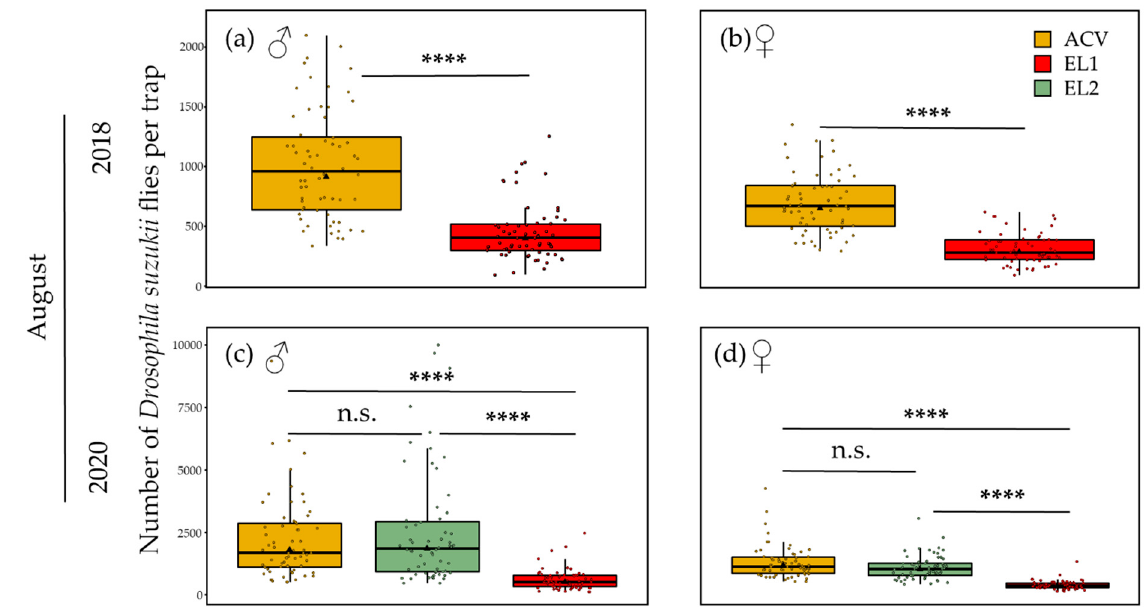
Figure 8. Number of D. suzukii flies per trap per sex and attractant in August. Jittered points and boxplots represent the 64 replicate traps and their distribution, respectively. Black triangles represent the estimated marginal mean number of D. suzukii flies per trap (GLMM). Lines connecting boxplots with asterisks above indicate the level of significance regarding the difference in the estimated marginal means of different attractants (GLMM, * p ≤ 0.05, ** p ≤ 0.01, *** p ≤ 0.001, **** p ≤ 0.0001, n.s.: not significant). ( a ) In August 2018, significantly more males were caught with ACV than with EL1. ( b ) For the females, the same was observed. ( c , d ) In 2020, for both males and females, ACV and EL2 did not significantly differ in fly catches, but both caught significantly more flies than EL1.